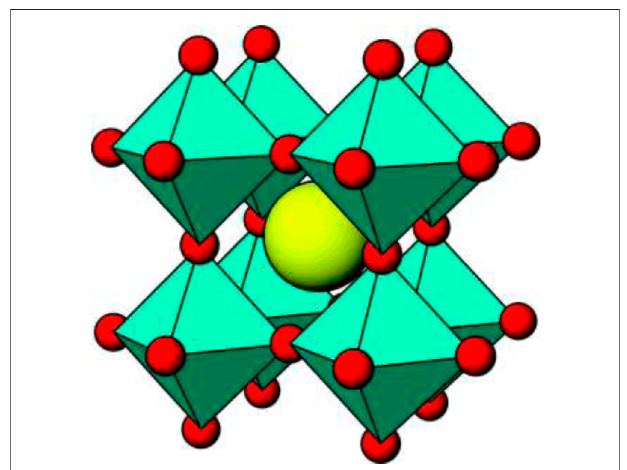
FIGURE 1 | Ideal cubic perovskite structure for ABO3 (cyan, BO 6 units; yellow, A atoms; Kubacka et al.